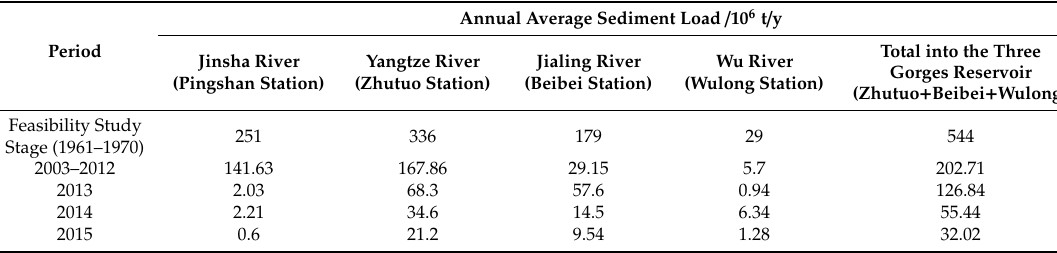
Table 7. Statistics of sediment load into the Three Gorges